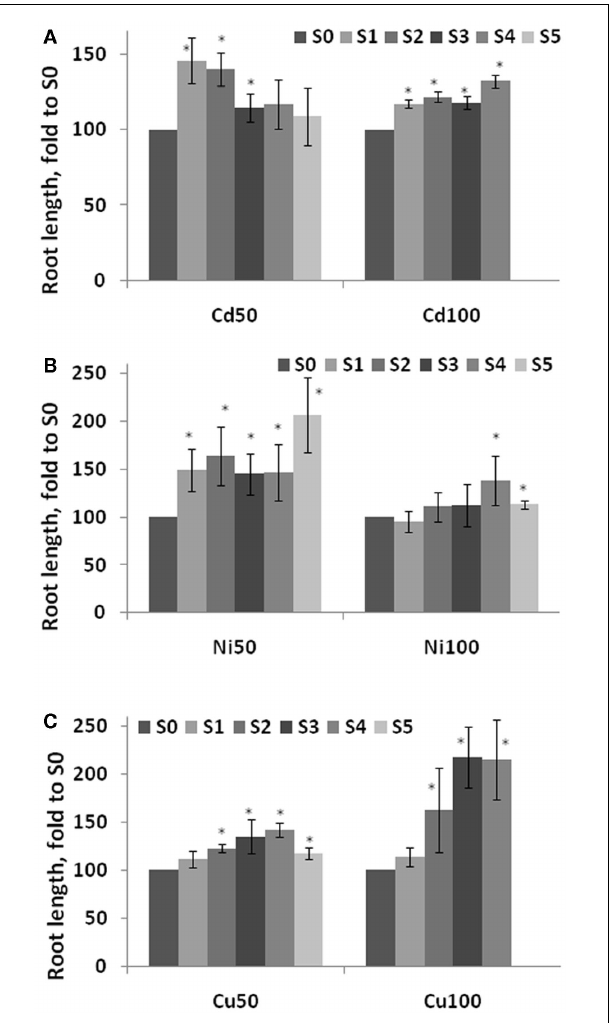
FIGURE 7 | Root length in the progeny of stressed plants exposed to high concentration of methyl methane sulfonate (MMS). Root length was measured in five consecutive generations of plants exposed to 50 and 100mM Cd 2 + (A) , 50 and 100mM Ni 2 + (B) , and 50 and 100mM Cu 2 + (C) as well as non-exposed plants. Plants were germinated and grown on MS medium supplemented with 45ppm MMS and roots were measured at 2weeks post-germination.The vertical axis shows the average (with SD, calculated from three independent experiments) root length in S1–S5 plants, shown as percentage difference compared to the root length in S0 plants. Asterisks indicate a significant difference between the individual group of S1–S5 plants and S0 plants (Student’s t -test, p < 0.05 in each